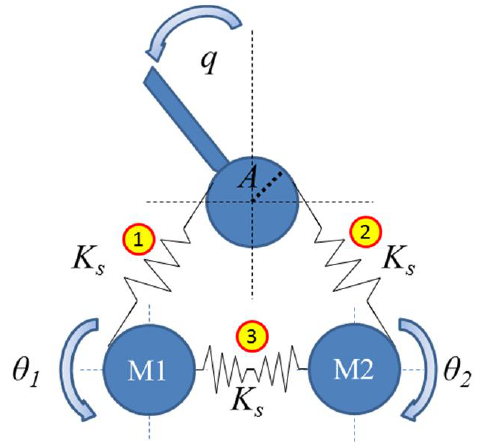
Figure 3. Cross-coupled class of stiffness adjustment